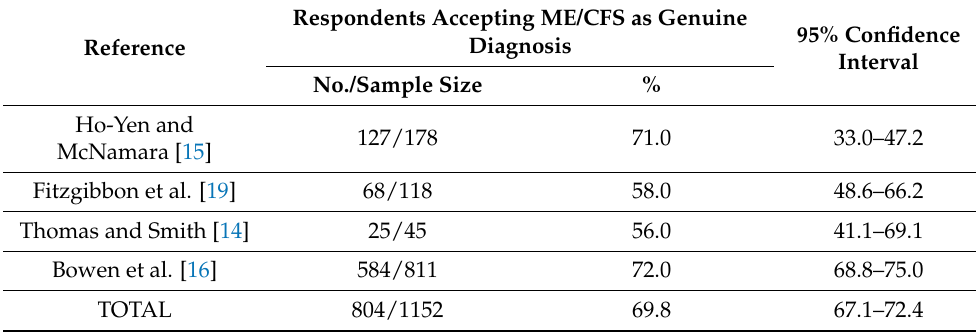
Table 4. Acceptance by GPs of ME/CFS—summary statistics.